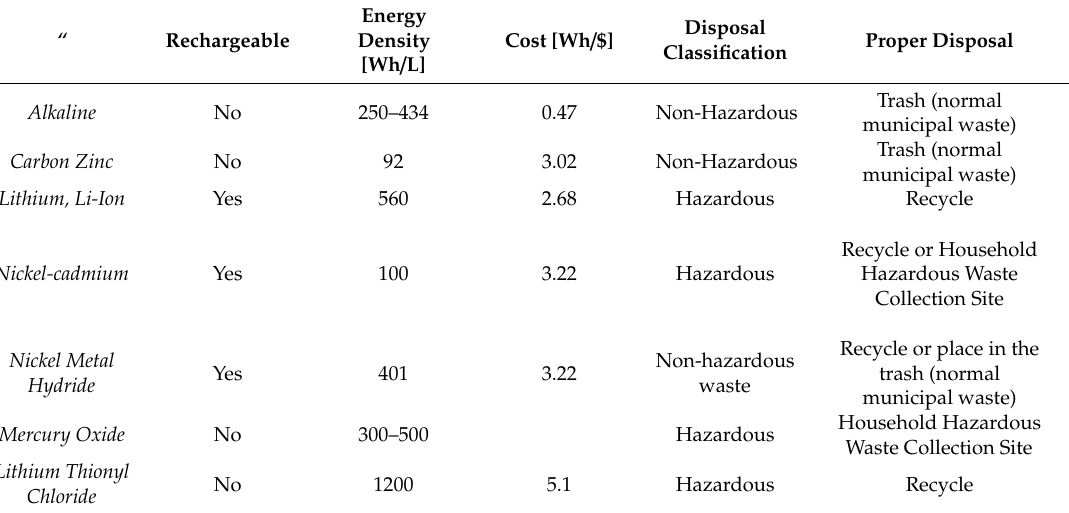
Table 3. Classification of battery technologies mostly used for RFID